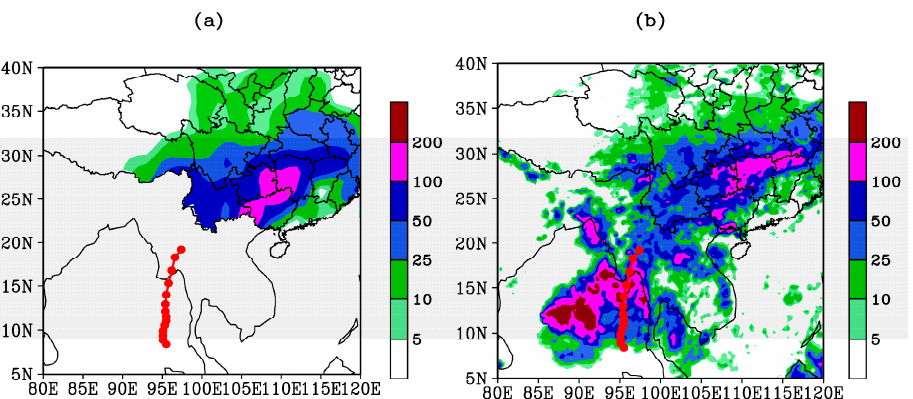
Figure 2. 72-h accumulated precipitation (units: mm) from 11 to 13 May 2002 obtained from ( a ) the China Meteorological Administration and ( b ) the Tropical Rainfall Measuring Mission. The red lines indicate TC trajectories.